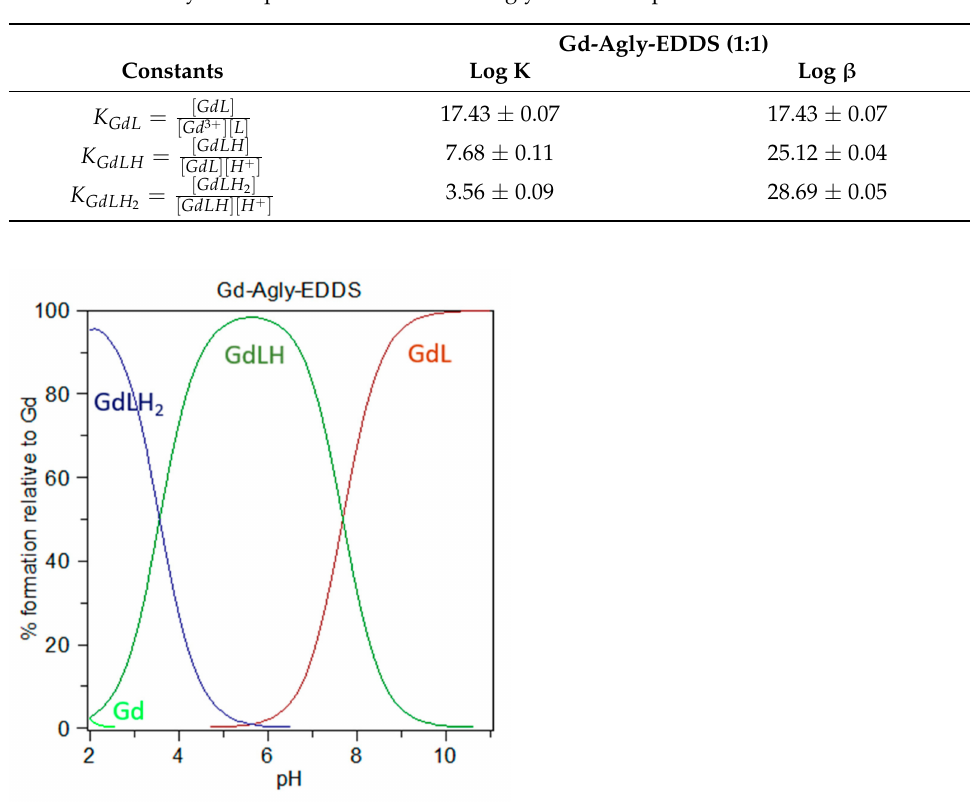
Table 3. Thermodynamic parameters for 1:1 Gd-Agly-EDDS complex.